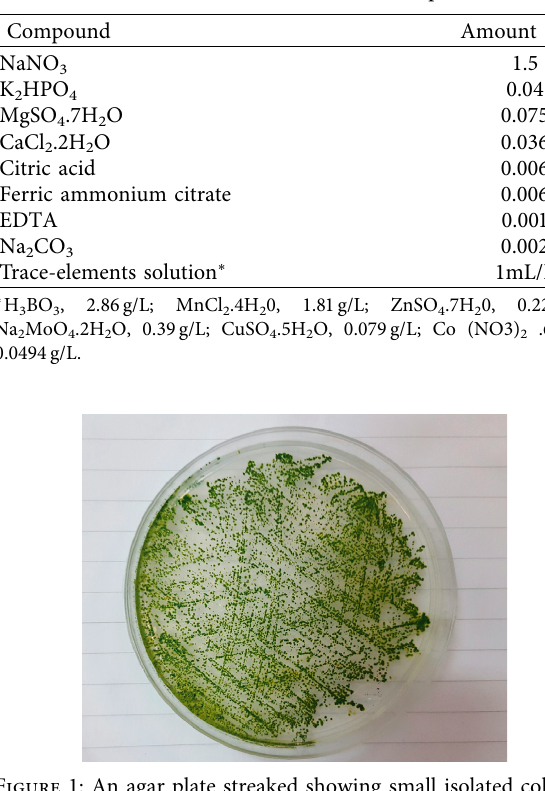
Table 1: BG-11 culture medium composition.